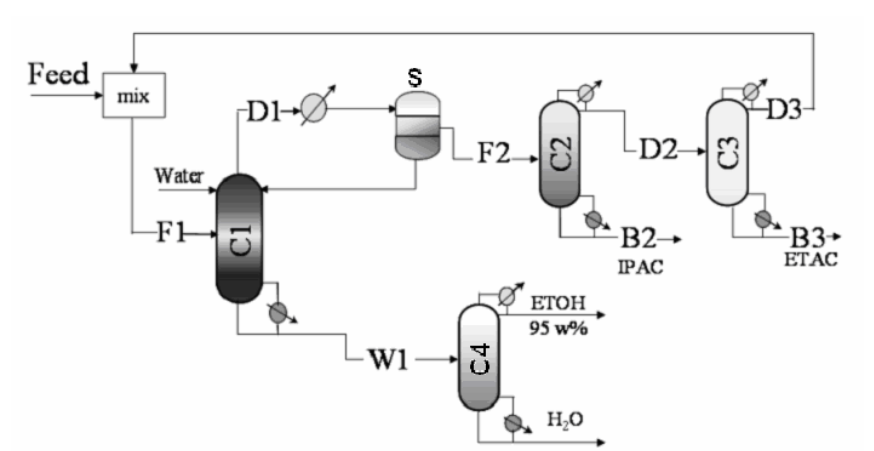
Fig. 2 EHAD scheme for the separation of the waste solvent stream [20].